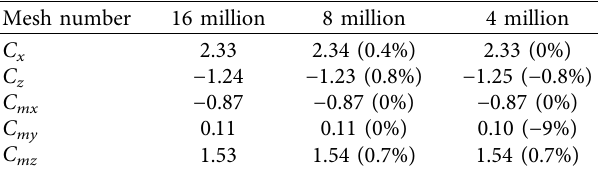
Figure 5: Computational domain and mesh division. (a) Computational domain; (b) mesh division around the model. Table 2: CFD mesh-independence verification for V � 28m/s with K � 0.11. Data in parentheses are the percentage differences in aerodynamic coefficient values between the current number and the finest mesh number (solid plate